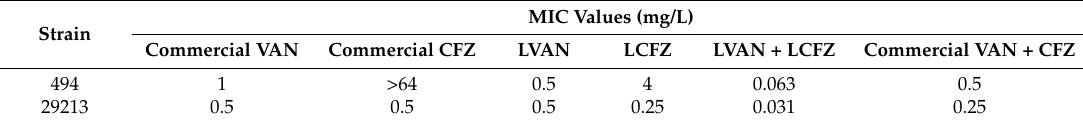
Table 1. MIC values of VAN and CFZ (commercial and liposomal) for 494 and 29213 strains. Strain